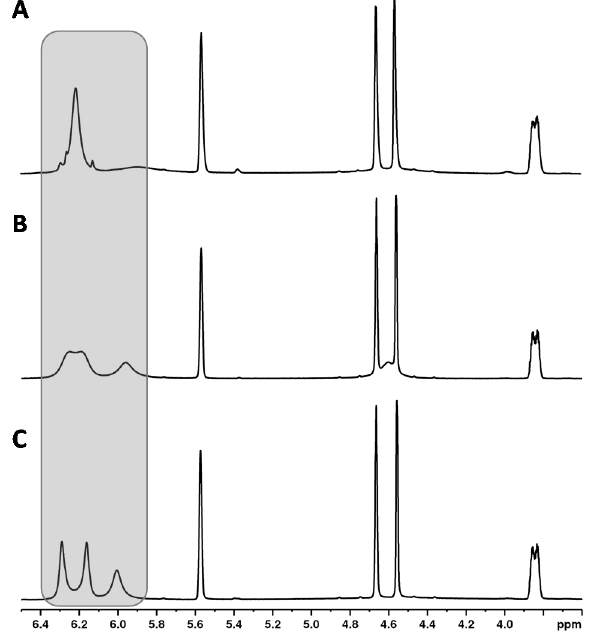
Figure 3. 1 H NMR spectra of CBD recorded at ( A ) 315 K, ( B ) 300 K, ( C ) 285 K.